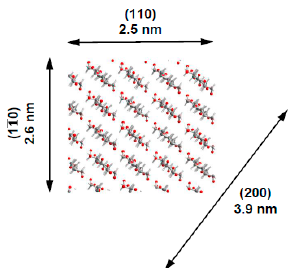
Figure 7. Cross-section of elementary crystallites in CNC particles. Projection of cellulose molecules is clearly visible. The indexation of corresponding lattice planes is described according to the monoclinic unit cell of allomorph I ß [55].